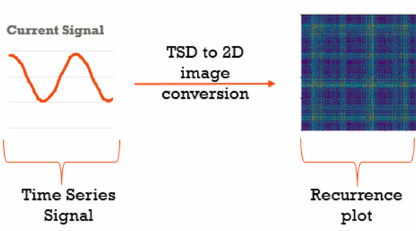
Figure 1. Feature representation. Time-series data into a 2D (Two dimensional) texture images (recurrence plot).